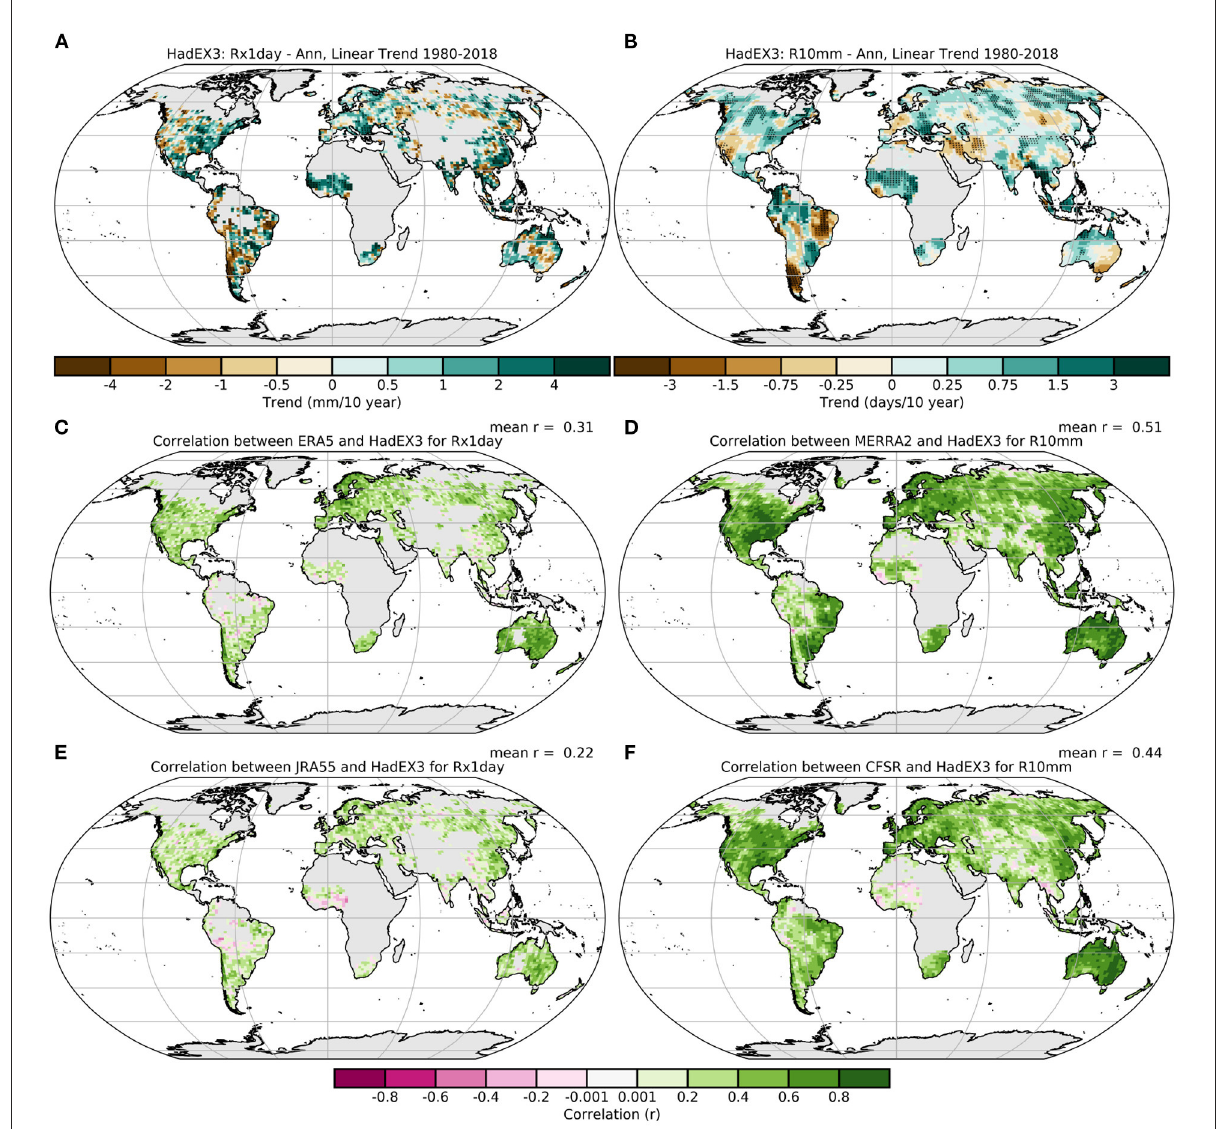
FIGURE9 (A,B) Linear trends in Rx1day (mm/decade) and R10mm (days/decade) in HadEX3. Correlation maps for (C,E) Rx1day, and (D,F) R10mm (anomalies relative to 1981–2010) with a selection of reanalyses (ERA5, MERRA-2, JRA-55, and